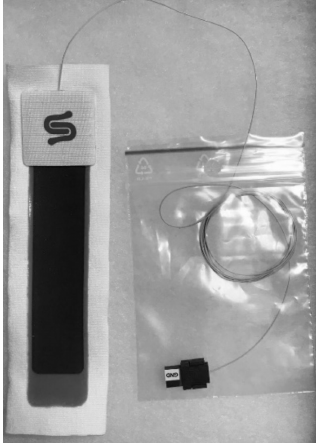
Figure 7. StretchSense™ StretchFABRIC sensor hasa fabric substrate. The polymer housing that protects the sensor is affixed to the substrate via an